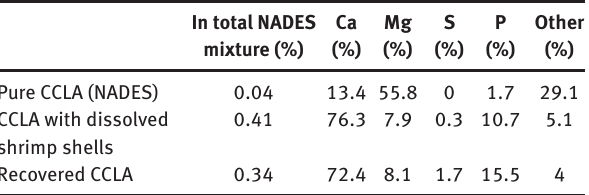
Table 5: Percentage of Ca, Mg, S and other elements in the NADES mixtures excluding CH and 2